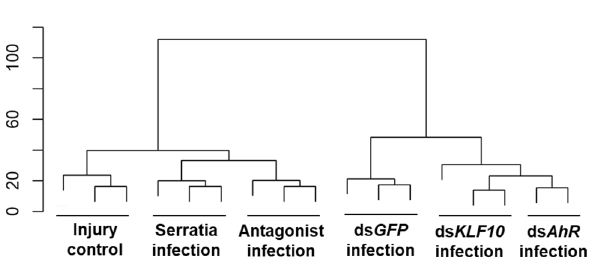
Figure 3. Clustering of transcriptomes in response to Serratia challenge. The scale bar represents the distance between the